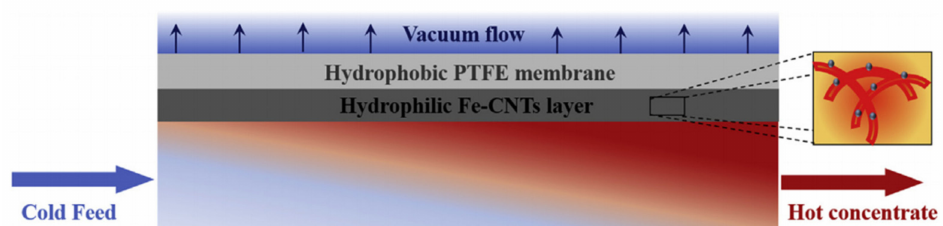
Figure 21. Illustration of the induction heated (IH)-VMD process. Bottom layer: temperature profile in the feed; Middle layer: composite membrane; Top: vacuum chamber. Right image: enlargement of the Fe-CNTs layer [50]. Reproduced with permission from Elsevier, 2019.